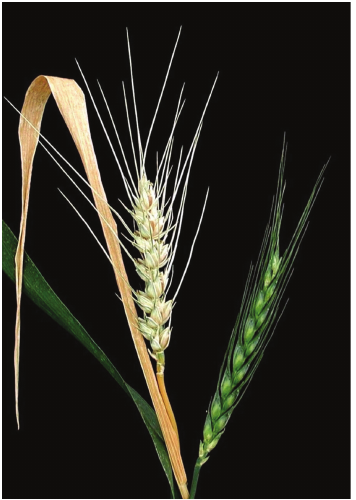
Figure 4: Plants treated with 5000 mg · L − 1 glufosinate ammonium during germination (on the right) had growing period three weeks longer than the untreated control ones (on the left).